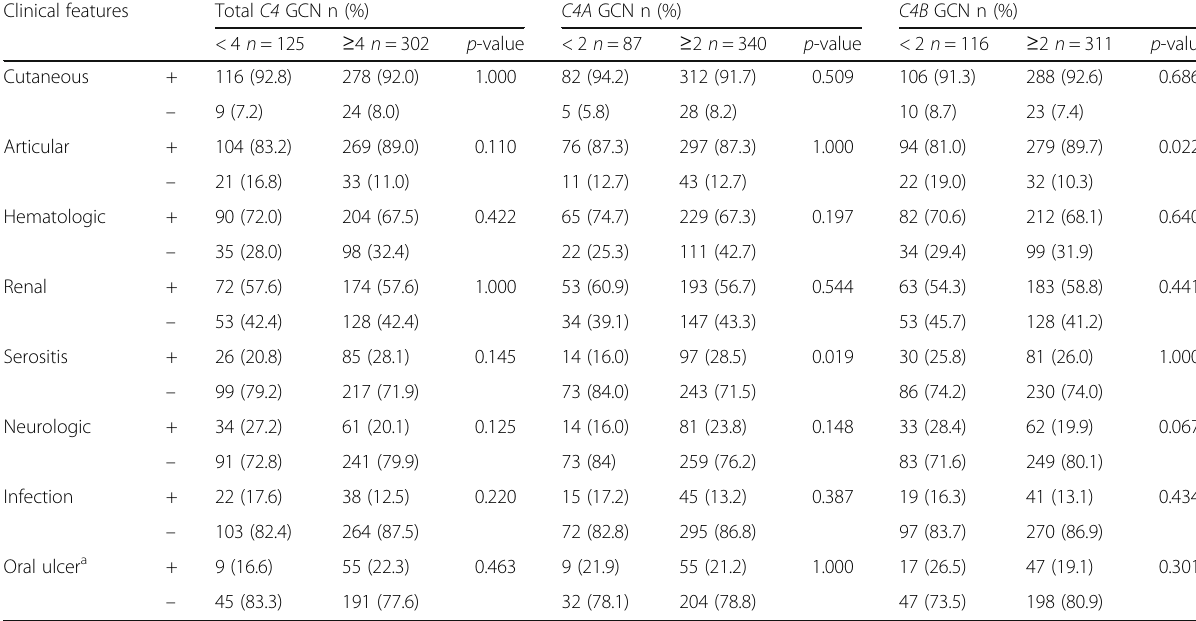
Table 5 SLE clinical manifestations according to total C4 , C4A and C4B gene copy number (GCN) Clinical features